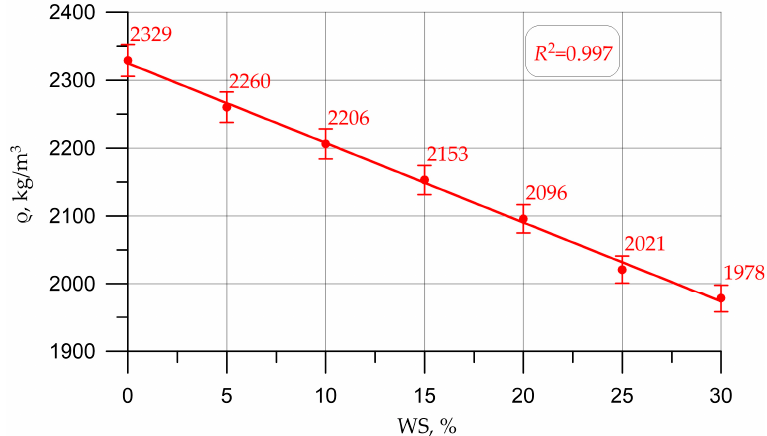
Figure 5. Dependence of concrete density on the amount of walnut shell.